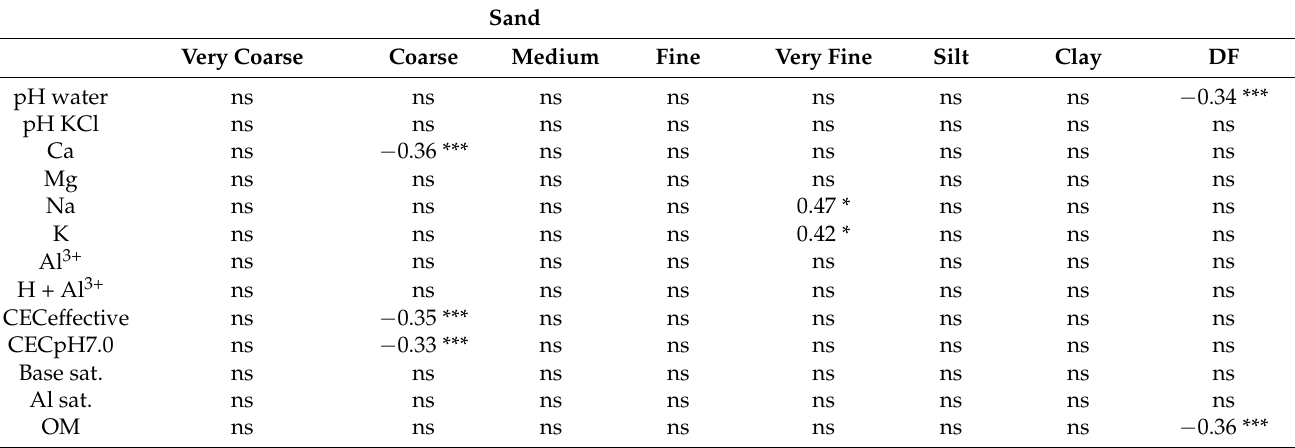
Table 10. Pearson’s correlation between the soil chemical variables and the particle size and degree of flocculation of Quartzipsamments of the Southwest of Rio Grande do Sul State, southern